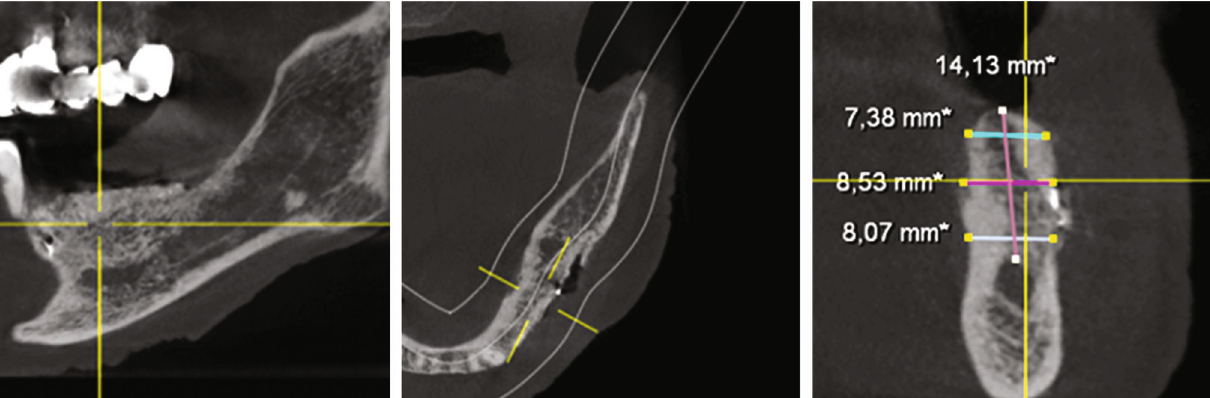
Figure 19: DVT — section; implant position region 35.